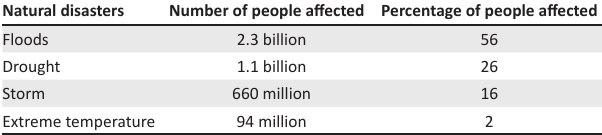
TABLE 1: Number of people affected by weather-related disasters (1995–2015). Natural disasters Number of people affected Percentage of people